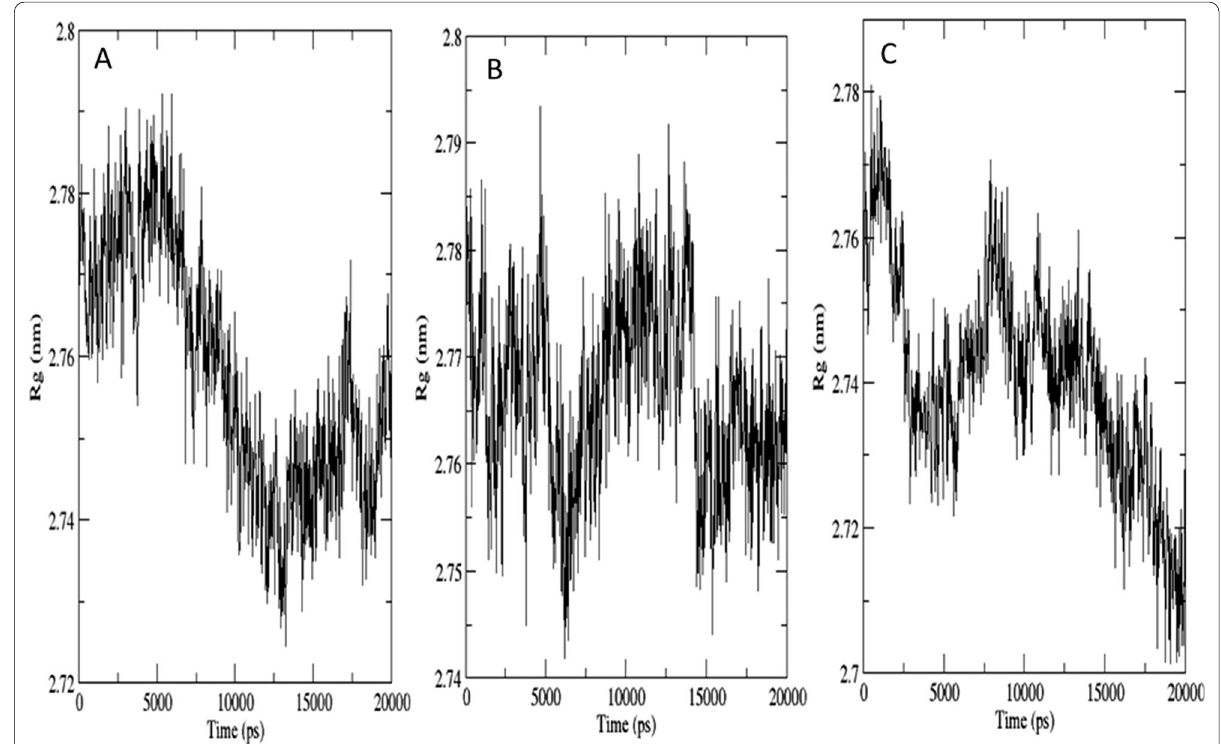
Fig. 10 Radii of gyration of: A isorhamnetin–XOD, B kaempferol–XOD and C quercetin–XOD complexes over a 20-ns simulation